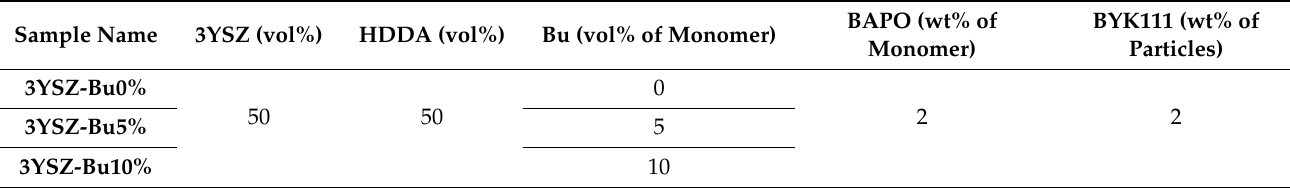
Table 1. Defined sample names of UV-curable 3YSZ (3 mol% yttria-stabilized zirconia) ceramic nanocomposite resins with different Bu